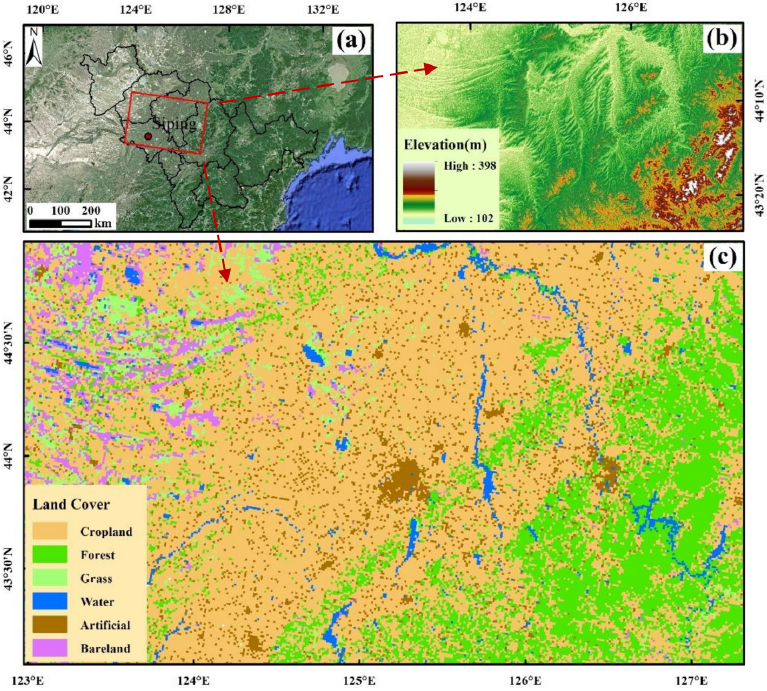
Figure 1. Location of the study area. ( a ) The red box represents the scope of the study area, which is located in the farmland area in the middle of Jilin Province; ( b ) the digital elevation map of the study area; and ( c ) the land cover classification from GlobeLand30 (http://www.globallandcover.com (accessed on 01 June